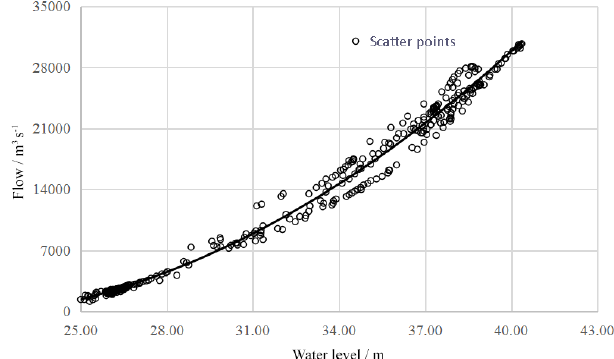
Figure 3. The scatter diagram with T − 6h time flow of Wuxuan and T time water level of downstream transverse